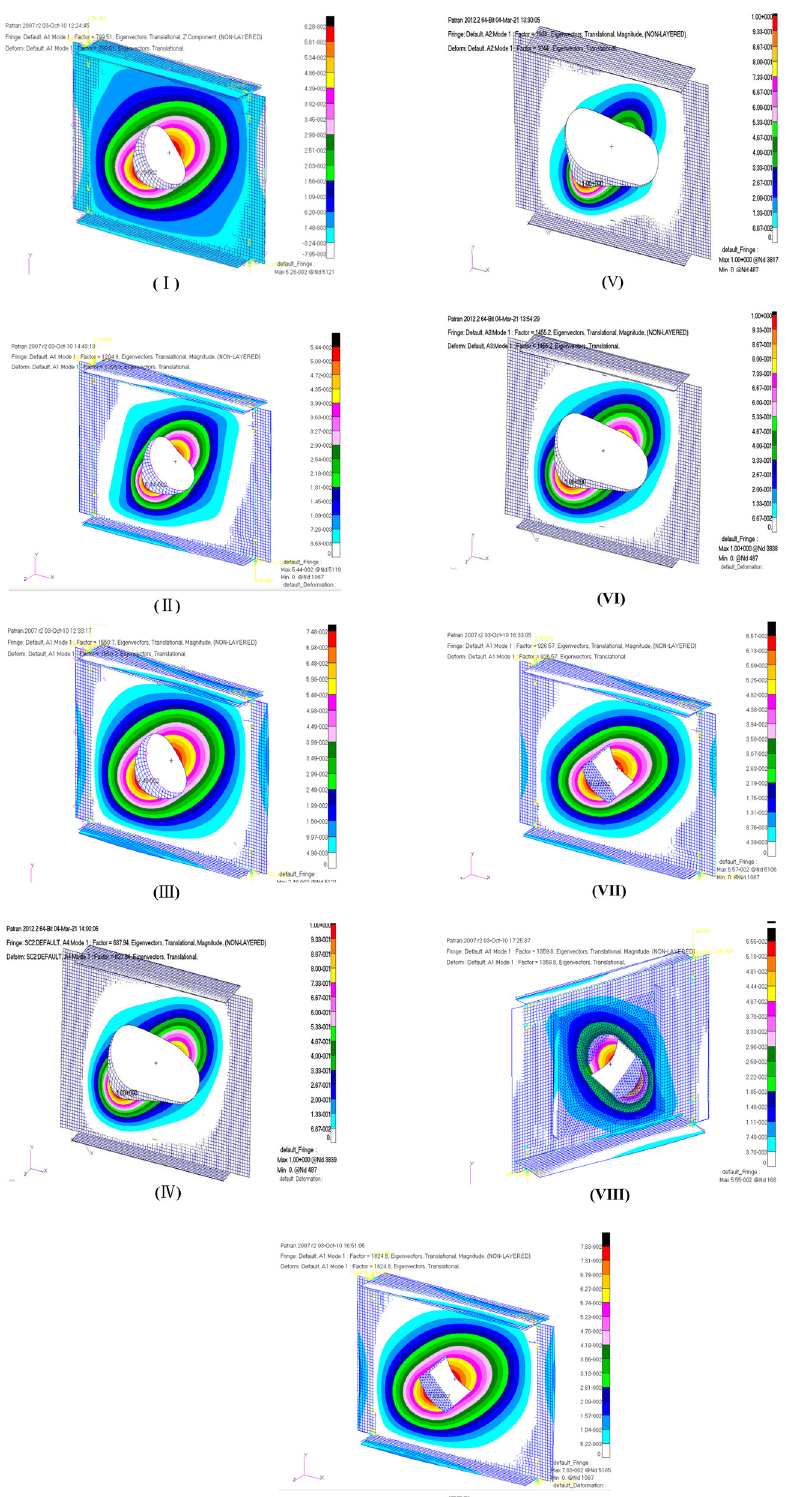
Figure 15: FEA bending analysis of a/b/c types: ( I ) FEA bending analysis of Sample a1. ( II ) FEA bending analysis of Sample a2. ( III ) FEA bending analysis of Sample a3. ( IV ) FEA bending analysis of Sample b1. ( V ) FEA bending analysis of Sample b2. ( VI ) FEA bending analysis of Sample b3. ( VII ) FEA bending analysis of Sample c1. ( VIII ) FEA bending analysis of Sample c2. ( IX ) FEA bending analysis of Sample